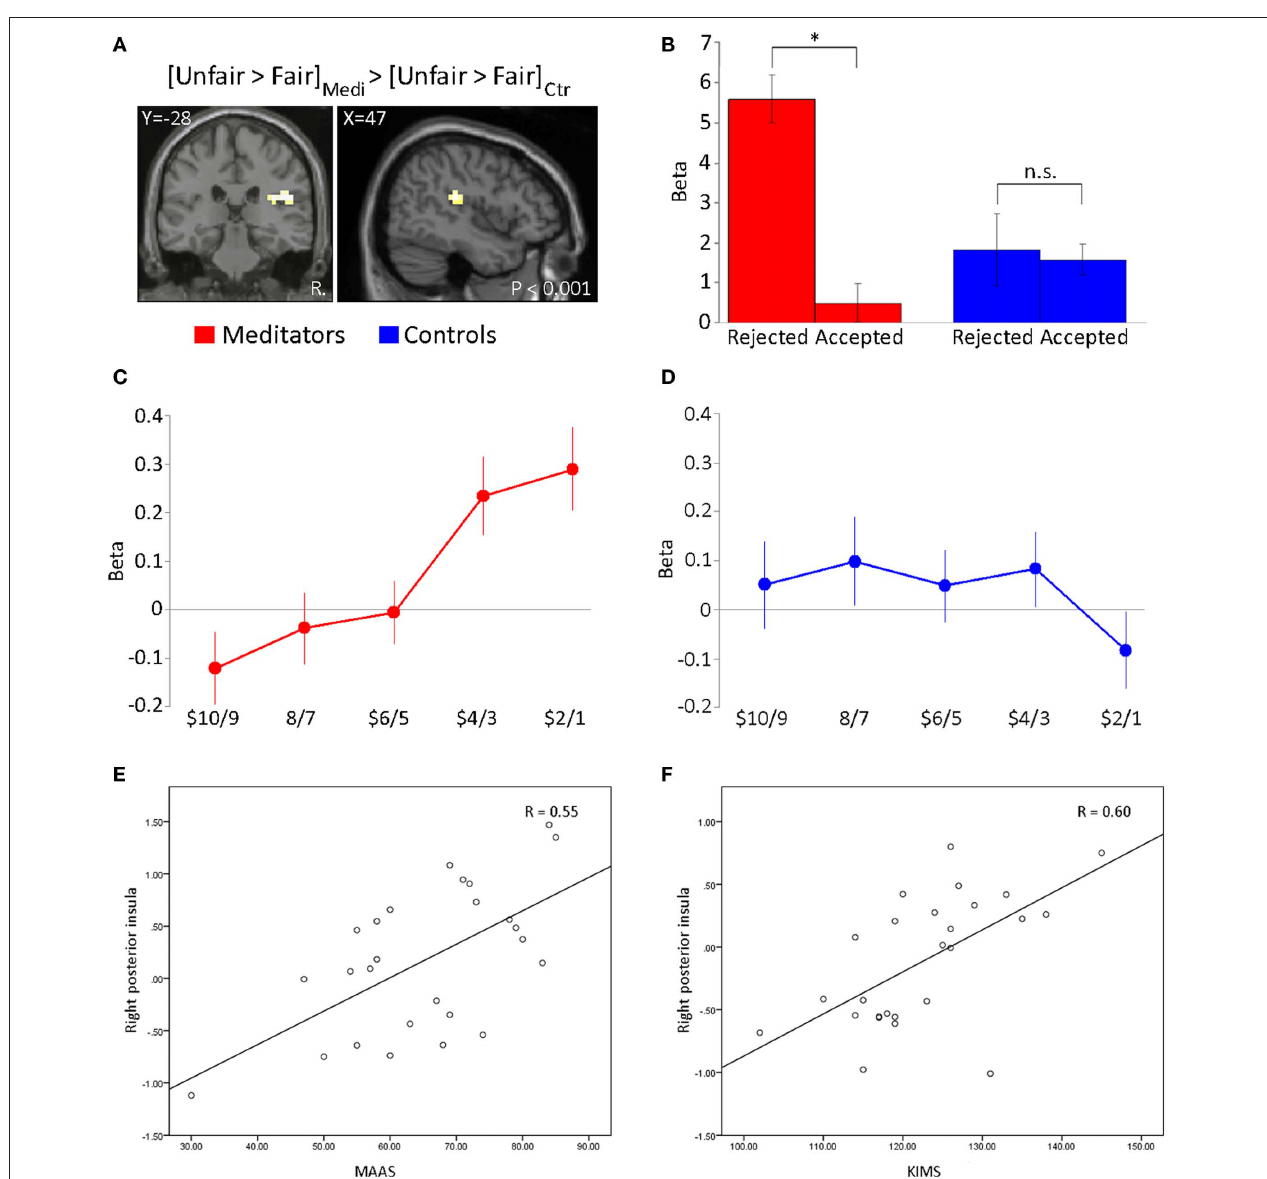
controls. (C,D) Average beta estimates from the voxels in the right posterior insula. The plots display a linear scaling with size of unfairness in meditators, which is not present in controls. Mean ± SE are plotted in increments of $2 bins. Activity within the right posterior insula in meditators is significantly correlated with individual differences in trait mindfulness levels as measured by (e) the Mindfulness Attention Awareness Scale (MAAS) and (F) the Kentucky Inventory of Mindfulness Skills (KIMS). The Pearson correlation coefficient (R) is given in the plot. Each data point represents a